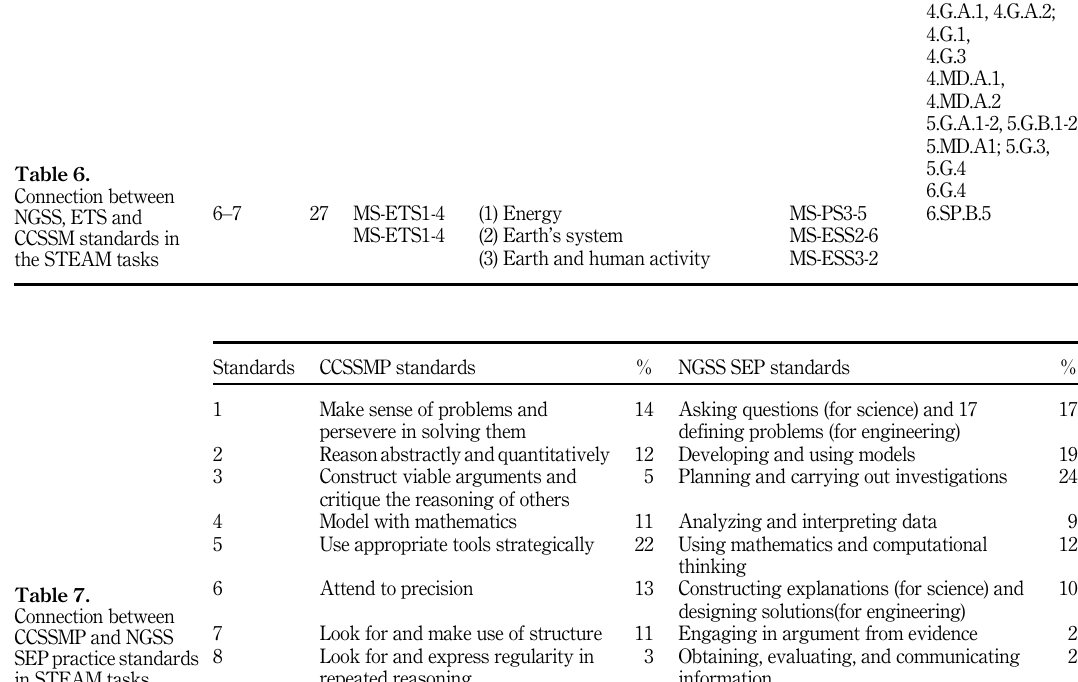
Table 7. Connection between CCSSMP and NGSS SEPpracticestandards in STEAM tasks